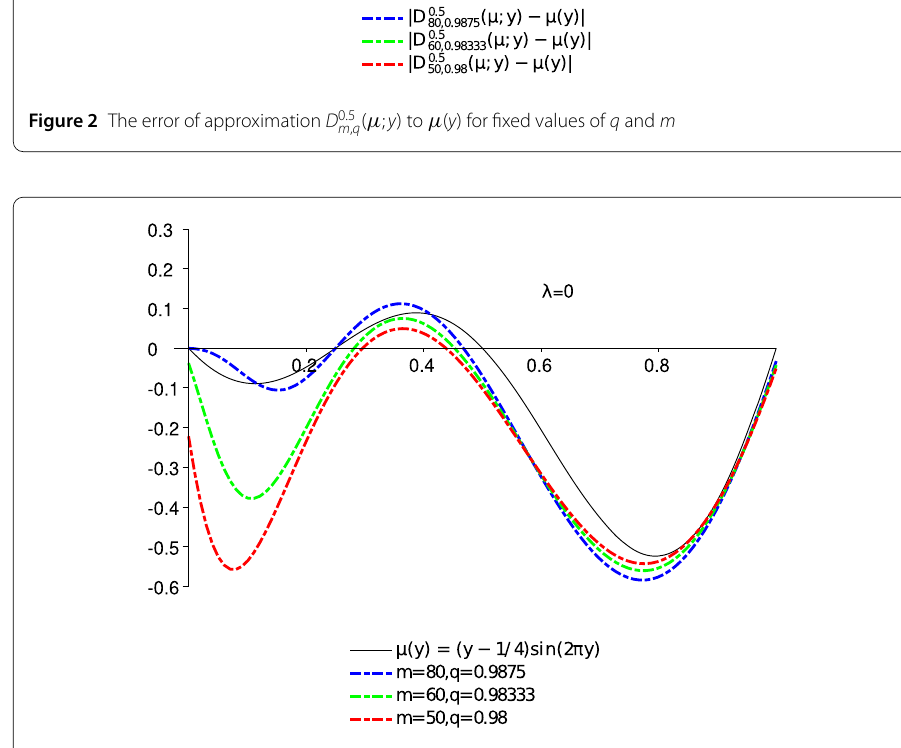
Figure 3 The approximation of D 0 m , q ( μ ; y ) to μ ( y ) for fixed values of q and